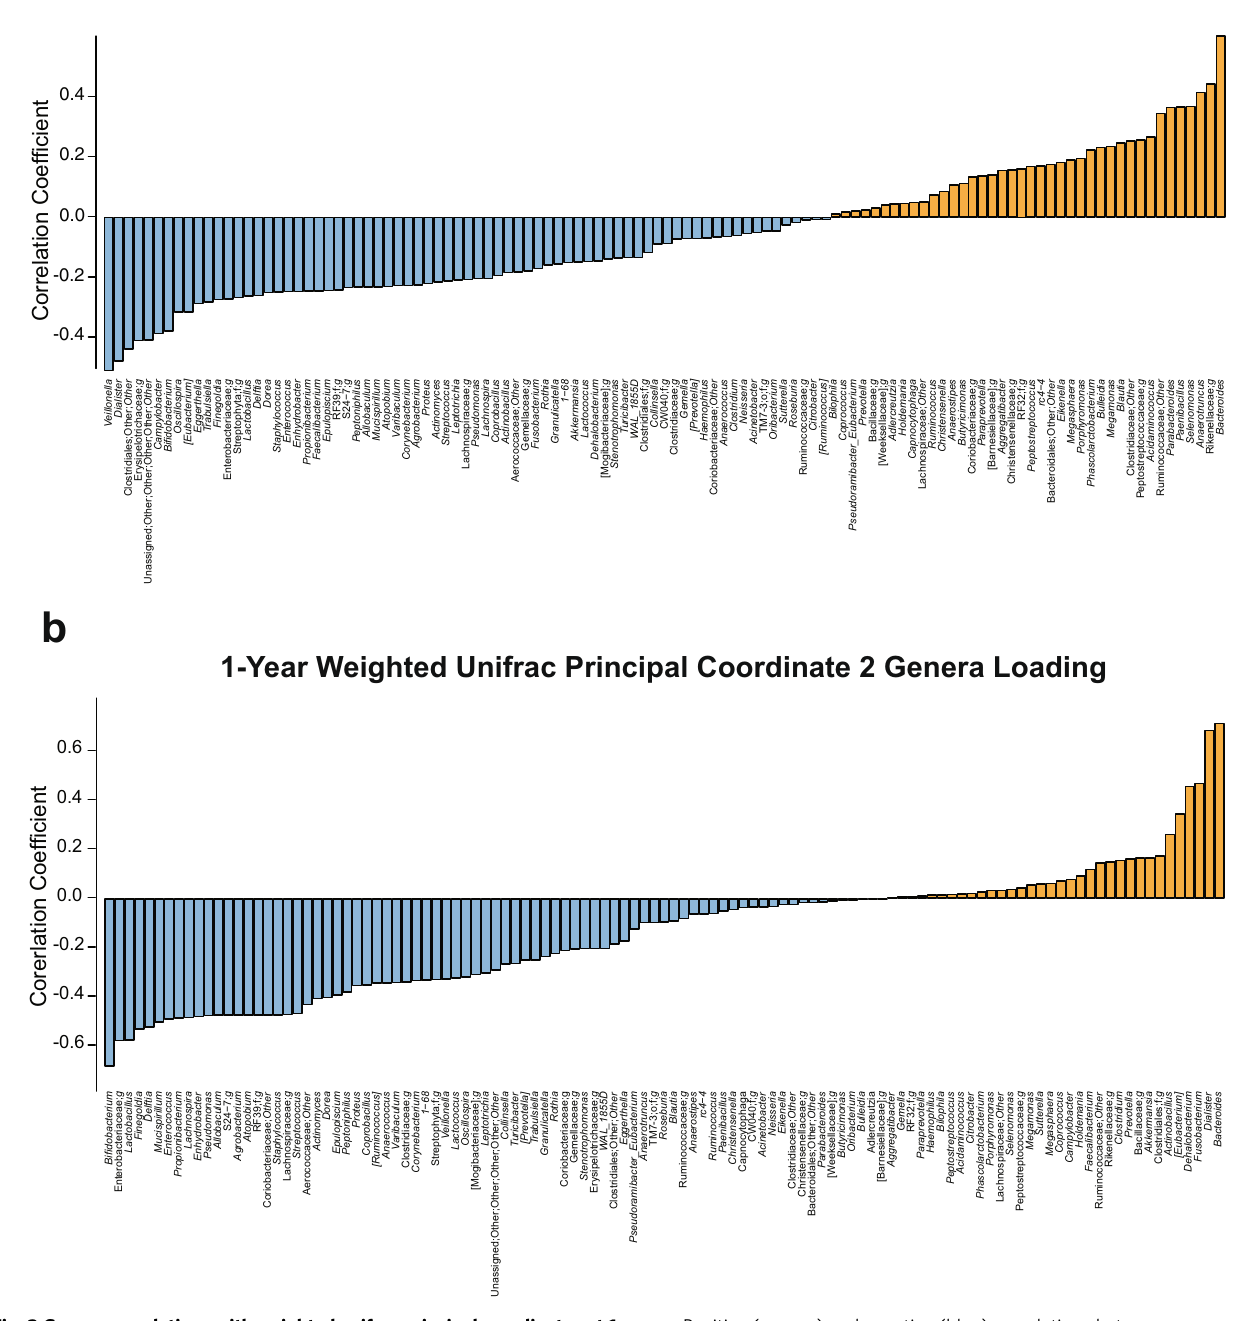
Fig. 3 Genera correlations with weighted unifrac principal coordinates at 1 year. a Positive (orange) and negative (blue) correlations between genera and beta diversity metric, Weighted Unifrac principal coordinate 1 at 1 year of age. b Positive (orange) and negative (blue) correlations between genera and beta diversity metric, Weighted Unifrac principal coordinate 2 at 1 year of age. Source data for this fi gure are provided as a Source Data fi